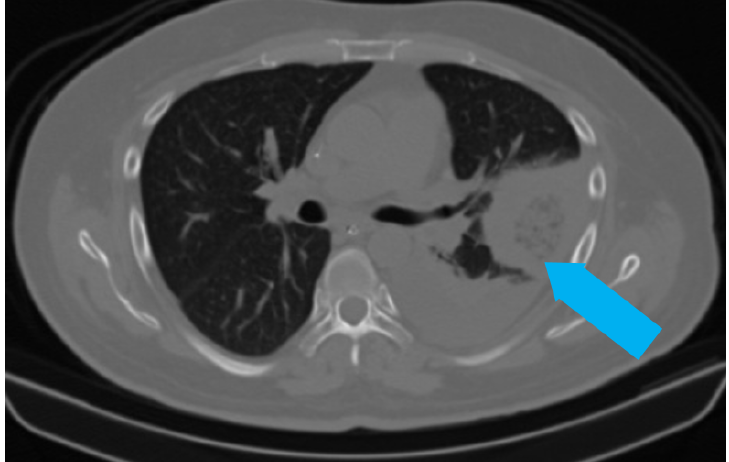
Figure 2. CT scan of the same patient showing a pleural-based consolidation with central clearing (blue arrow) and surrounding, denser, consolidation typical of reverse halo sign; also seen in left mild pleural